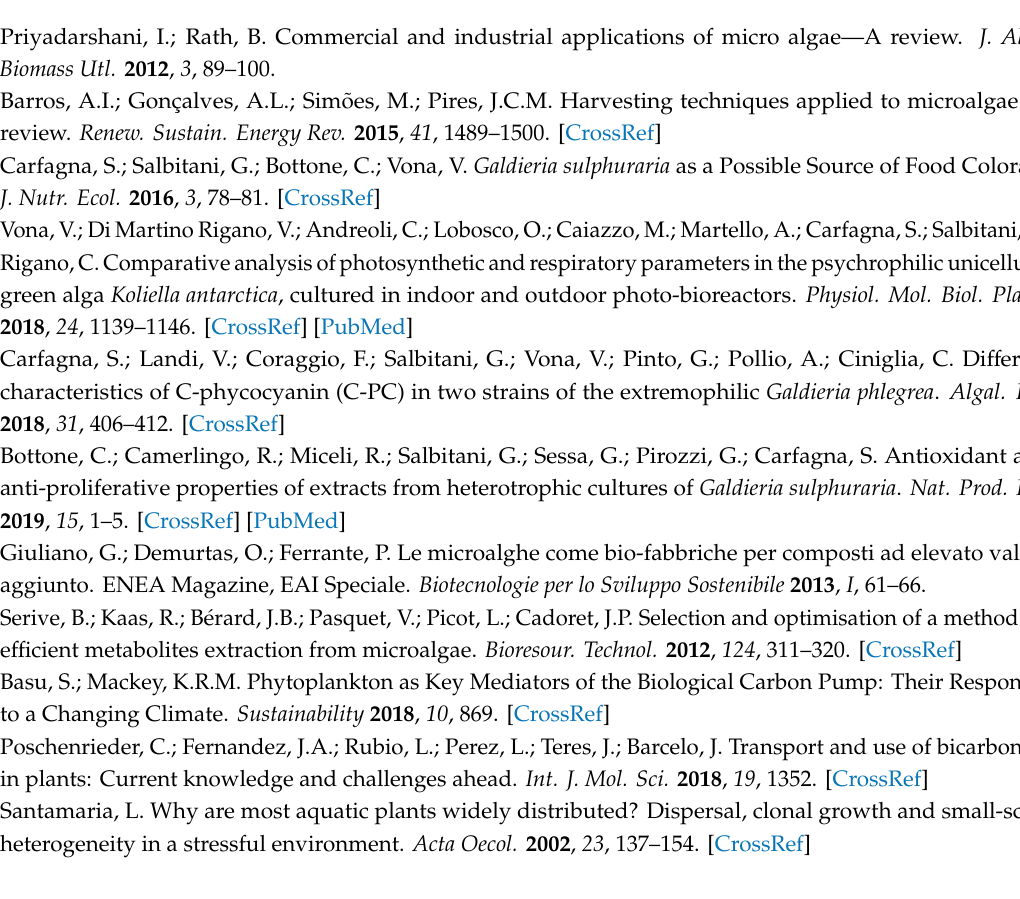
Figure S1: Pigment composition of Chlorella sorokiniana . Chromatogram in absorbance of eluted pigments, Table S1: Growth rate and doubling time in control and in sodium bicarbonate enriched cultures, Table S2. Time course of changes in pigments:chlorophyll a ratio in control and in sodium bicarbonate enriched